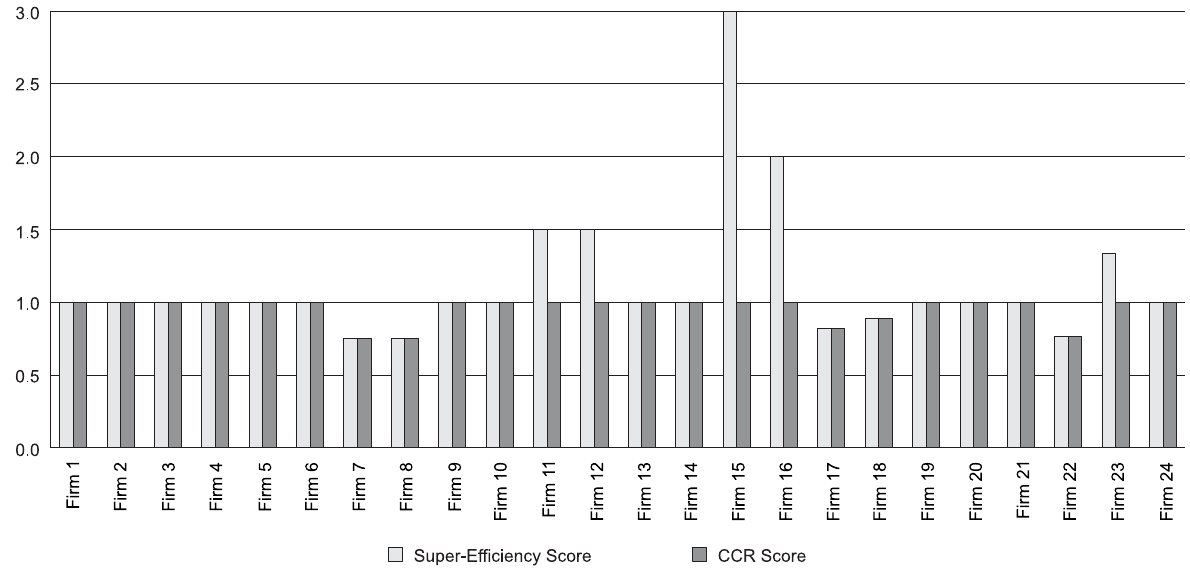
Fig. 2. Efficiency score based on the CCR model and the super-efficiency